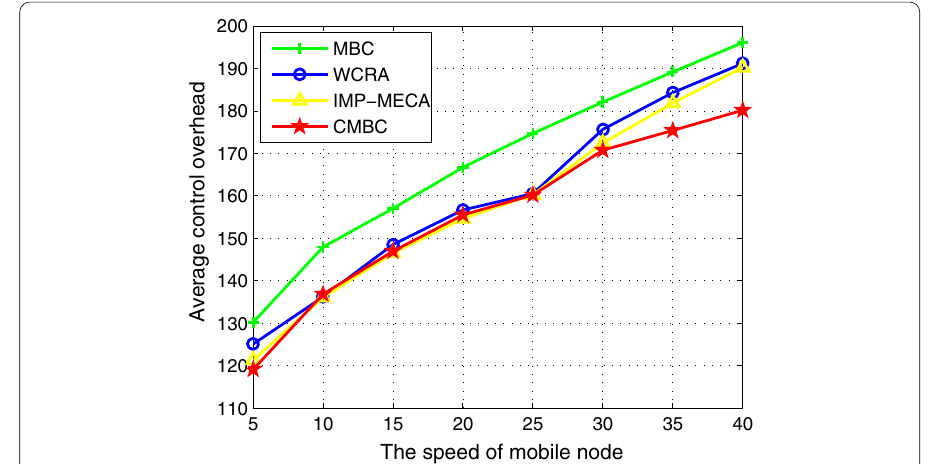
Fig. 10 Results comparison between the speed of mobile node and the average control